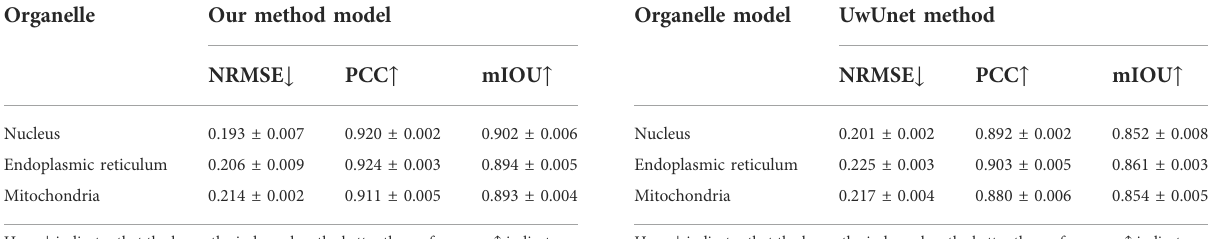
TABLE 2 Comparison of quality measures for labeling-free prediction results with the PLMFnet model.